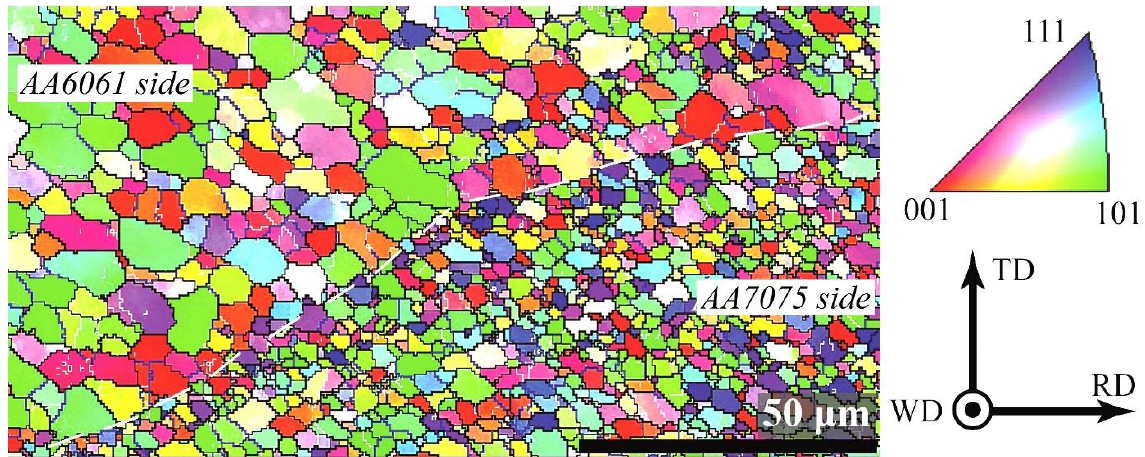
Figure 3. IPF maps of different areas in TMAZ of AA6061: ( a ) rectangle 1 in Figure 2a, and ( b ) rectangle 2 in Figure 2a. Black and white arrows refer to CDRX and GDRX mechanisms, respectively. The white circle indicates a grain in which the subdivision mechanism has occurred.